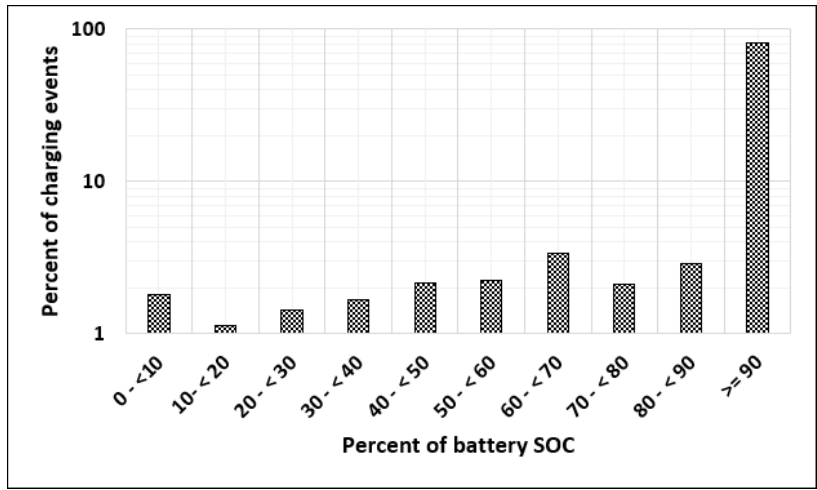
Figure 5. Battery state of charge at end of charging from home charger prior to driving [30].